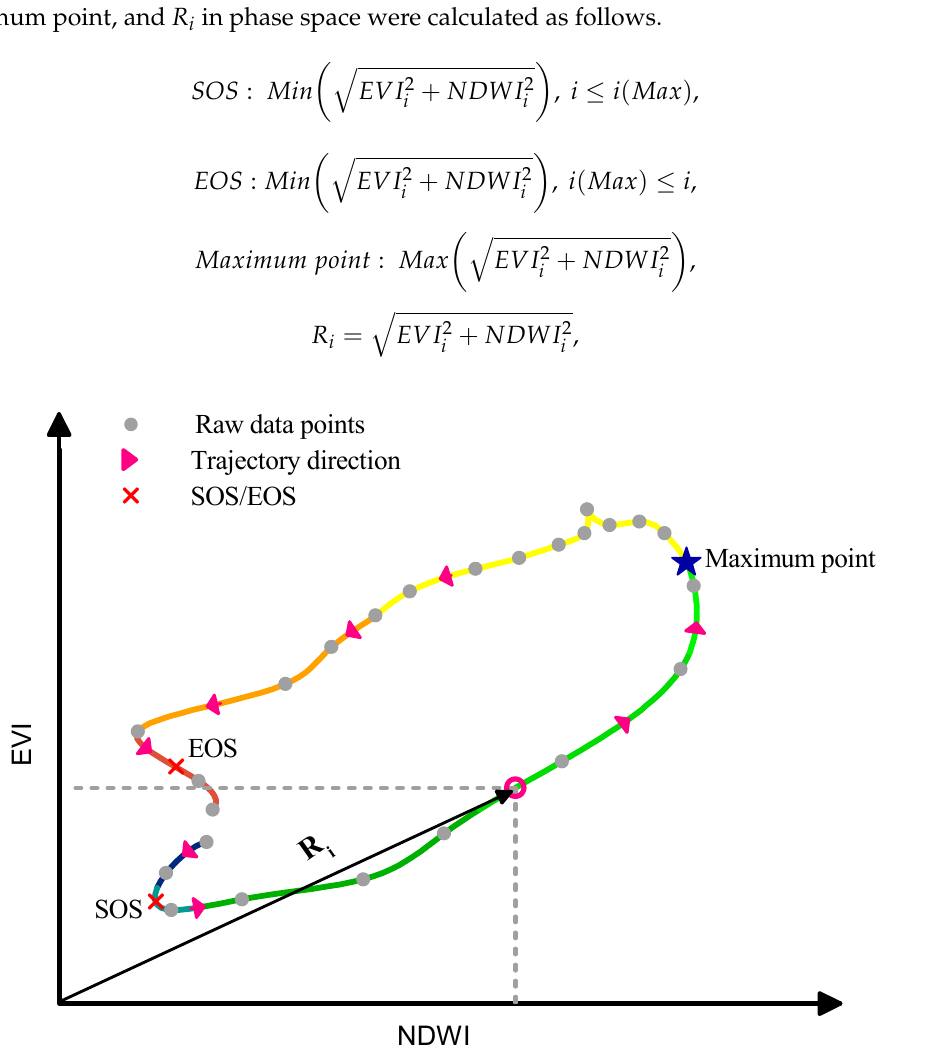
Figure 5. Rice phenological phase space and its phenological parameters, where SOS and EOS denote the beginning and the end of the rice growth period, respectively. Ri represents the distance from the data point of the i th day to the origin of the phase space and the maximum point is the data point that is farthest from the origin of the phase space.